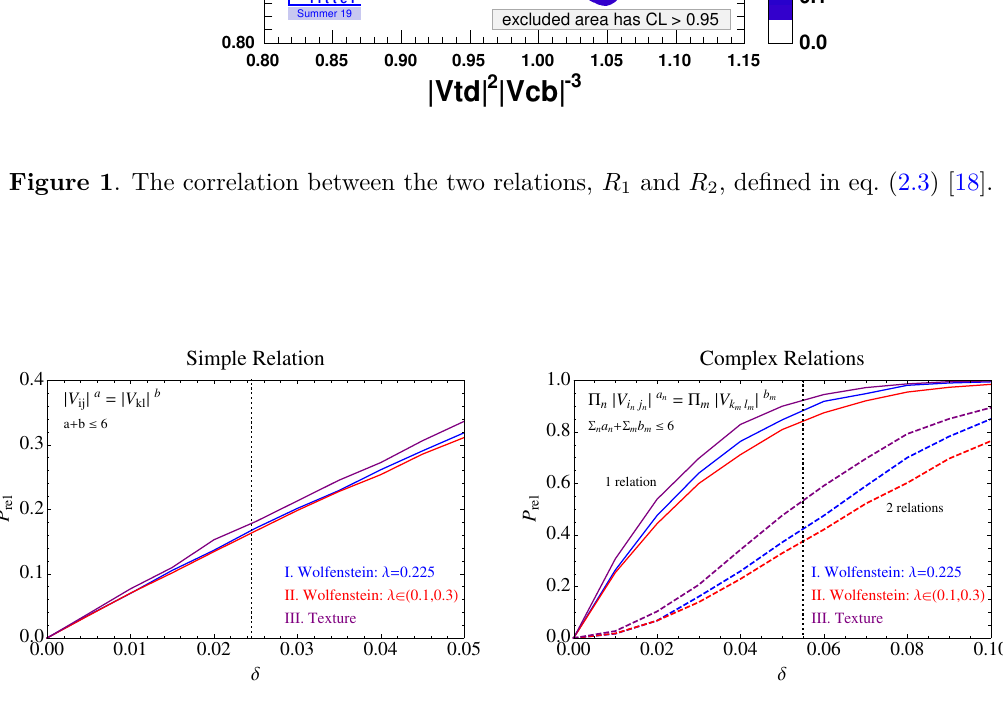
Figure 2 . Left : the probability of finding at least one simple relation, as defined in eq. (3.3), as a function of the precision, δ . Random CKM matrices are generated using Wolfenstein Anarchy with fixed λ (blue), Wolfenstein anarchy with random λ (red), and random Yukawa matrices using textures with random coefficients (purple). Parameters are randomly generated as described in eqs. (3.1), (3.2), and (3.6). Right : the probability of finding at least one (solid) or at least two (dashed) complex relations, as defined in eq. (3.4). The colors correspond to different scans, as on the left. The vertical black lines at δ = 0 . 0245 and δ = 0 . 055 , on the left and right, respectively, correspond to the (symmetrized) precision of the R 1 , 2 fits, see eq.